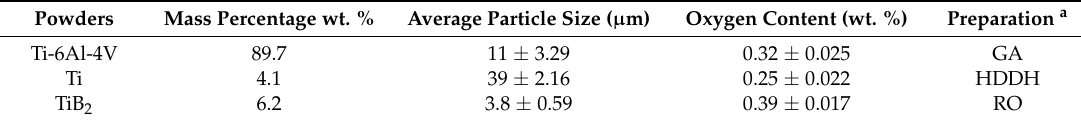
Table 1. Characteristics and content of raw